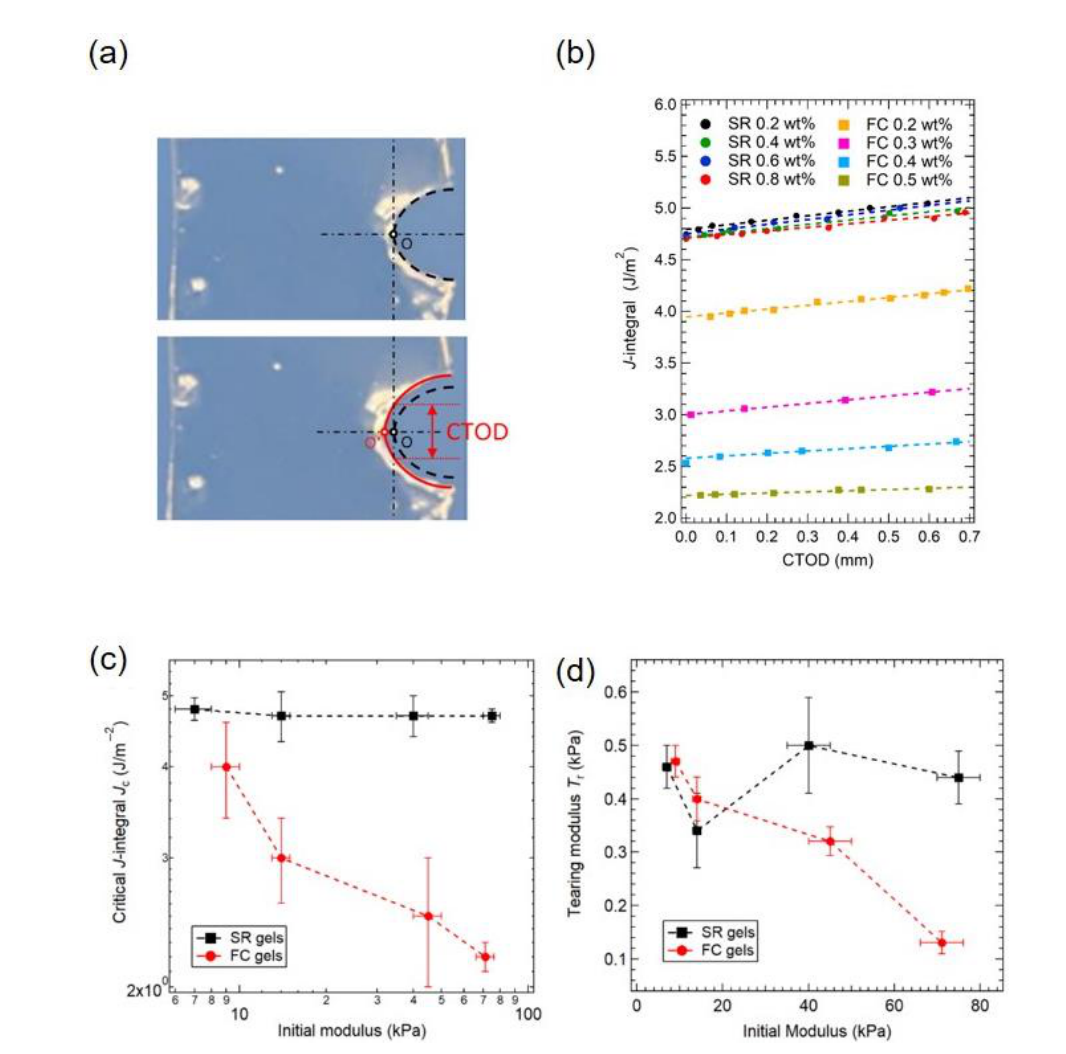
Figure 12. ( a ) Schematics for measuring crack tip opening displacement (CTOD), ( b ) J-integral — CTOD relationship of SR and FC gels with various cross-linker concentrations, ( c ) The initial modulus dependence of ( c ) critical J-integral J c and ( d ) tearing modulus T r of SR and FC gels. Reprinted from [30] with permission from Elsevier.